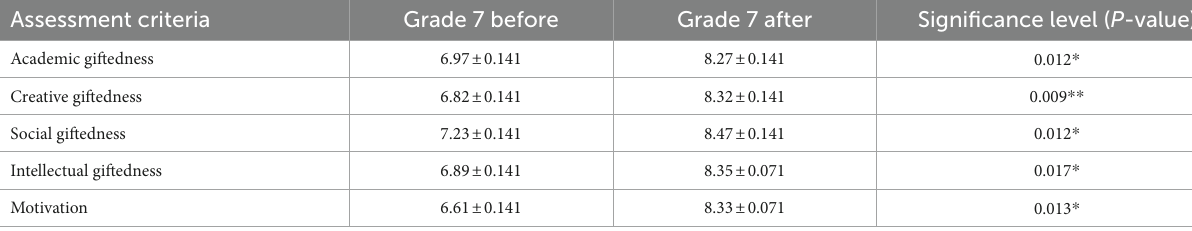
TABLE 4 Calculating class 7 results using student’s t -test. Assessment criteria Grade 7 before